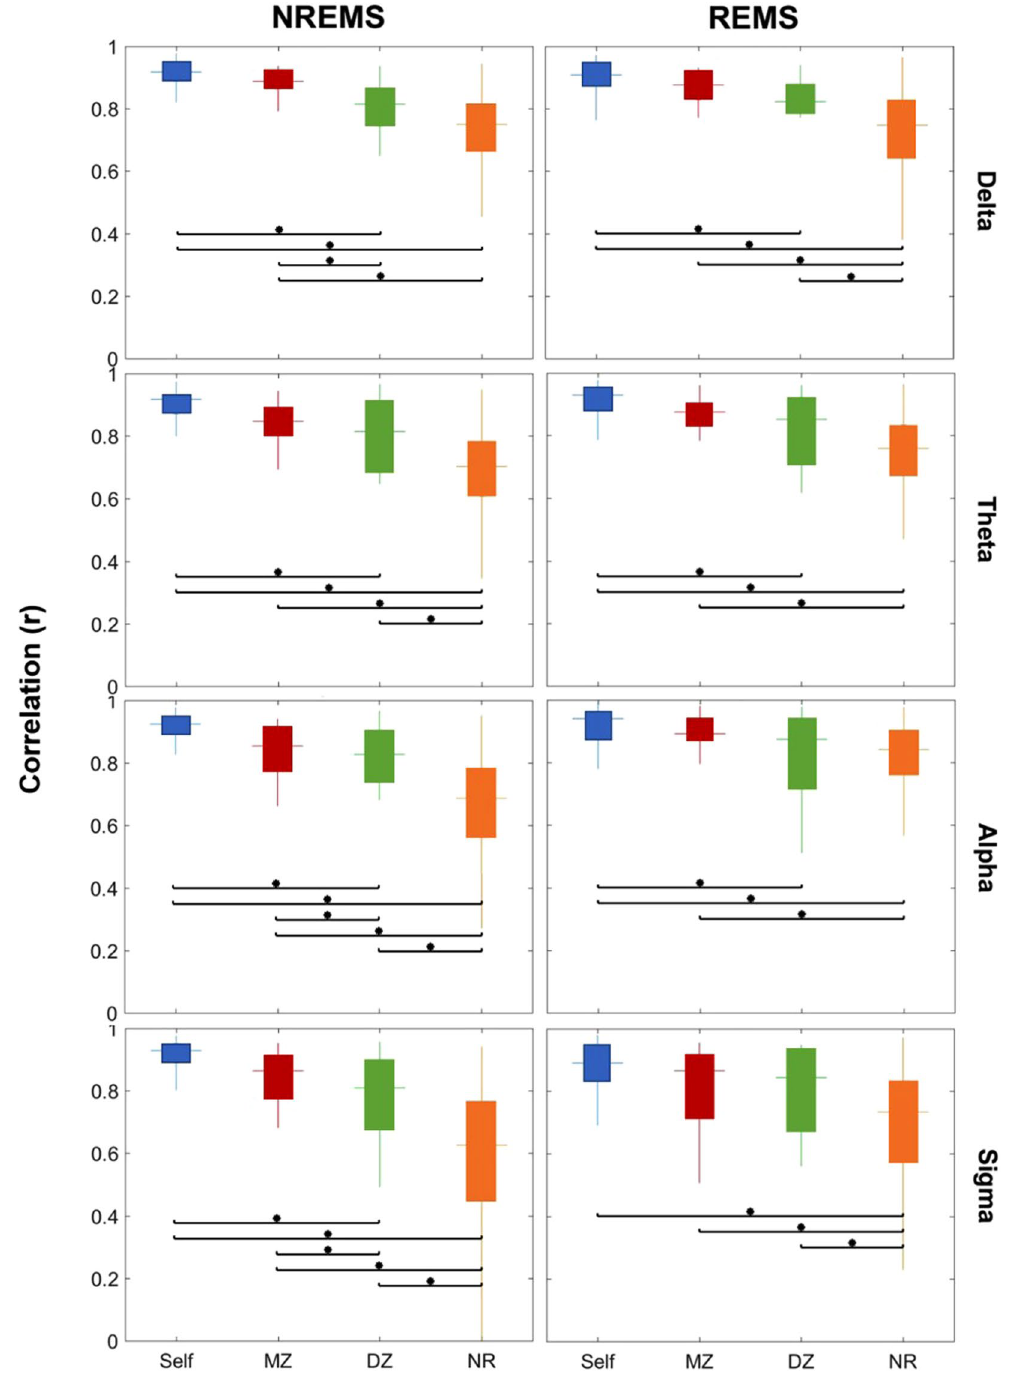
Figure 2. Box plots of correlation coefficients within each group, for the frequency bands delta, theta, alpha and sigma, and the two states, NREMS and REMS. The bottom and top edges of each box indicate the first and third quartiles, the central line indicates the median, and the maximum whisker length is defined as 1.5 times the interquartile range, ending at the maximum value in this range. Differences between the groups were evaluated by means of Tukey-corrected post-hoc t-tests on Fisher’s z-transformed values. The significant differences (p < 0.05) are depicted with an